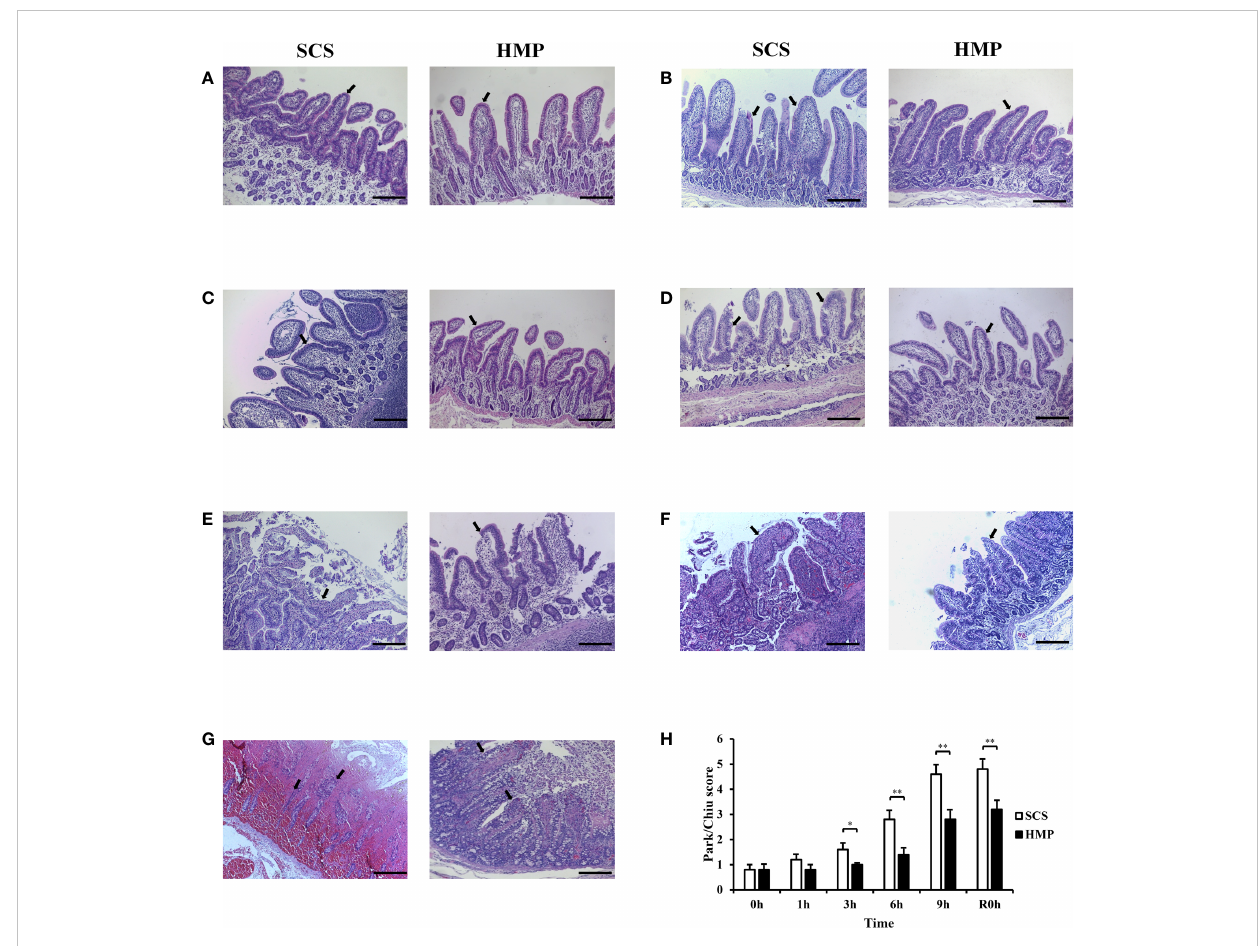
FIGURE 4 Protective effects of HMP on small intestine preservation. (A-G) Representative images H&E staining at 0h (A) 1h (B) 3h (C) 6h (D) 9h (E) R0h (F) POD7 (G) of the small intestine. (H) Evaluation of the Park/Chiu score. Villi changes and injuries of intestine were indicated by black arrows (original magni fi cation, x100; scale bar, 200 m m; n=5; *P <0.05, **P